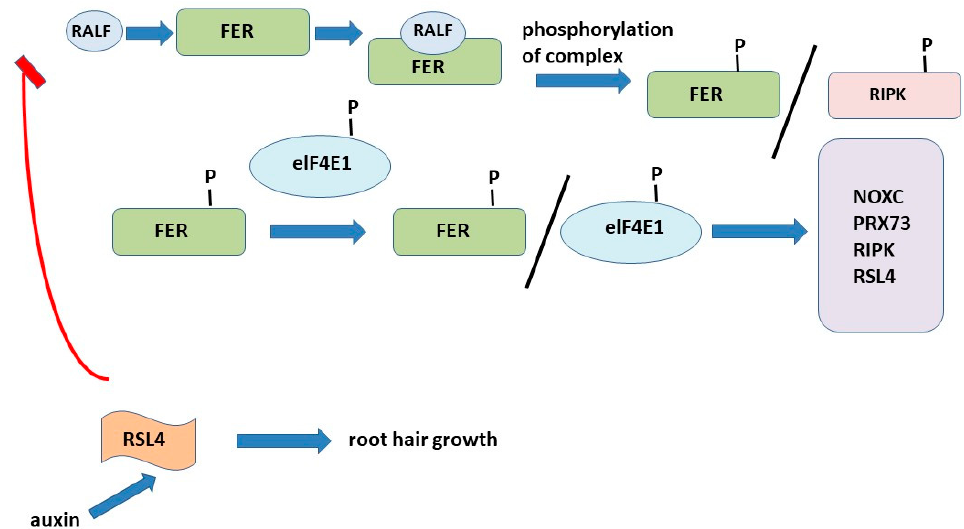
Figure 8. Negative feedback loop RALF1-FER-RSL4.